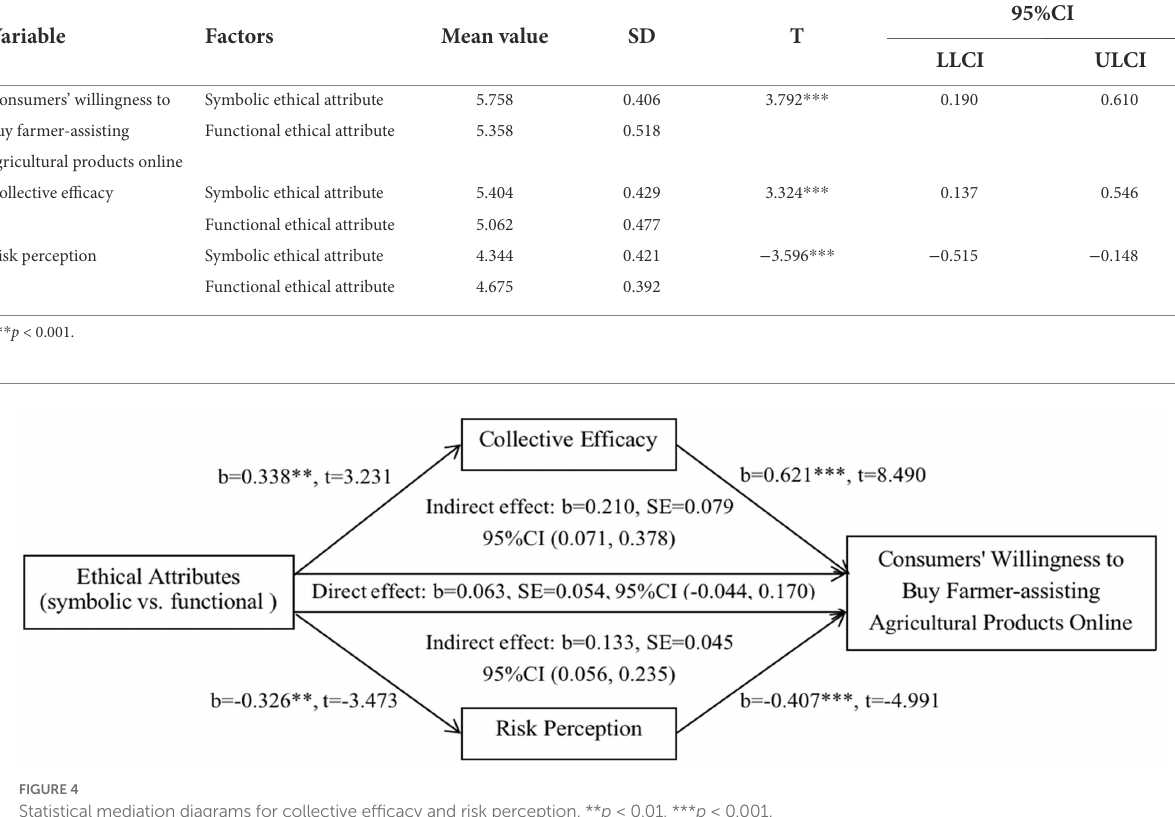
TABLE 5 Results of independent samples t -test.